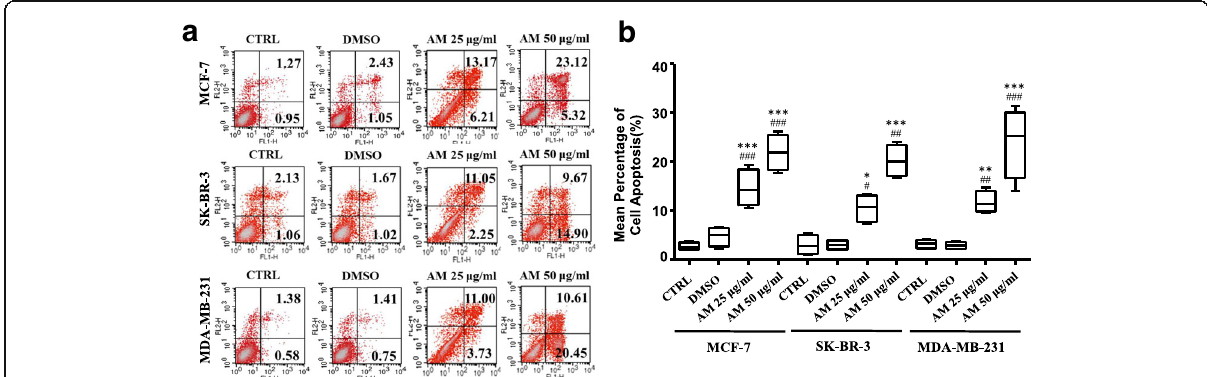
Fig. 4 Analysis of cell apoptosis induced by AM extract in three distinct breast cancer cell lines. Breast cancer cells were treated with 50 μ g/ml of AM extract for 24 h, and cell apoptosis was assessed by flow cytometry with FITC-Annexin V/PI Staining. The data are representative of three independent experiments carried out under the same conditions. * p < 0.05, ** p < 0.01, *** p < 0.001, compared with blank control group (CTRL); # p < 0.05, ## p < 0.01, ### p < 0.001, compared with DMSO